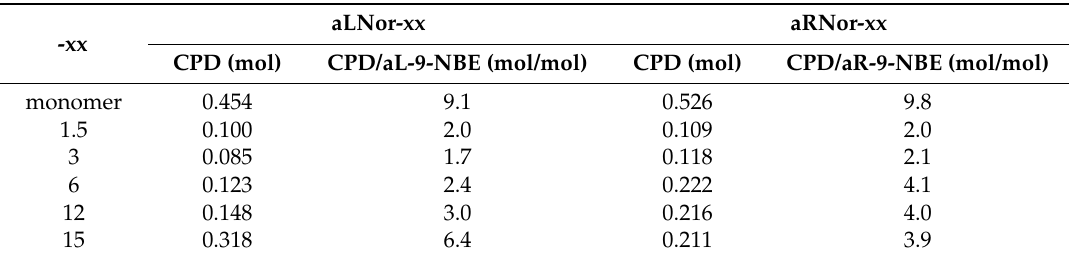
Table 5. Calculation of mol of CPD released via retro-Diels-Alder reaction during thermal decomposition of monomers aL-9-NBE and aR-9-NBE, and aerogels aLNor-xx and aRNor-xx.